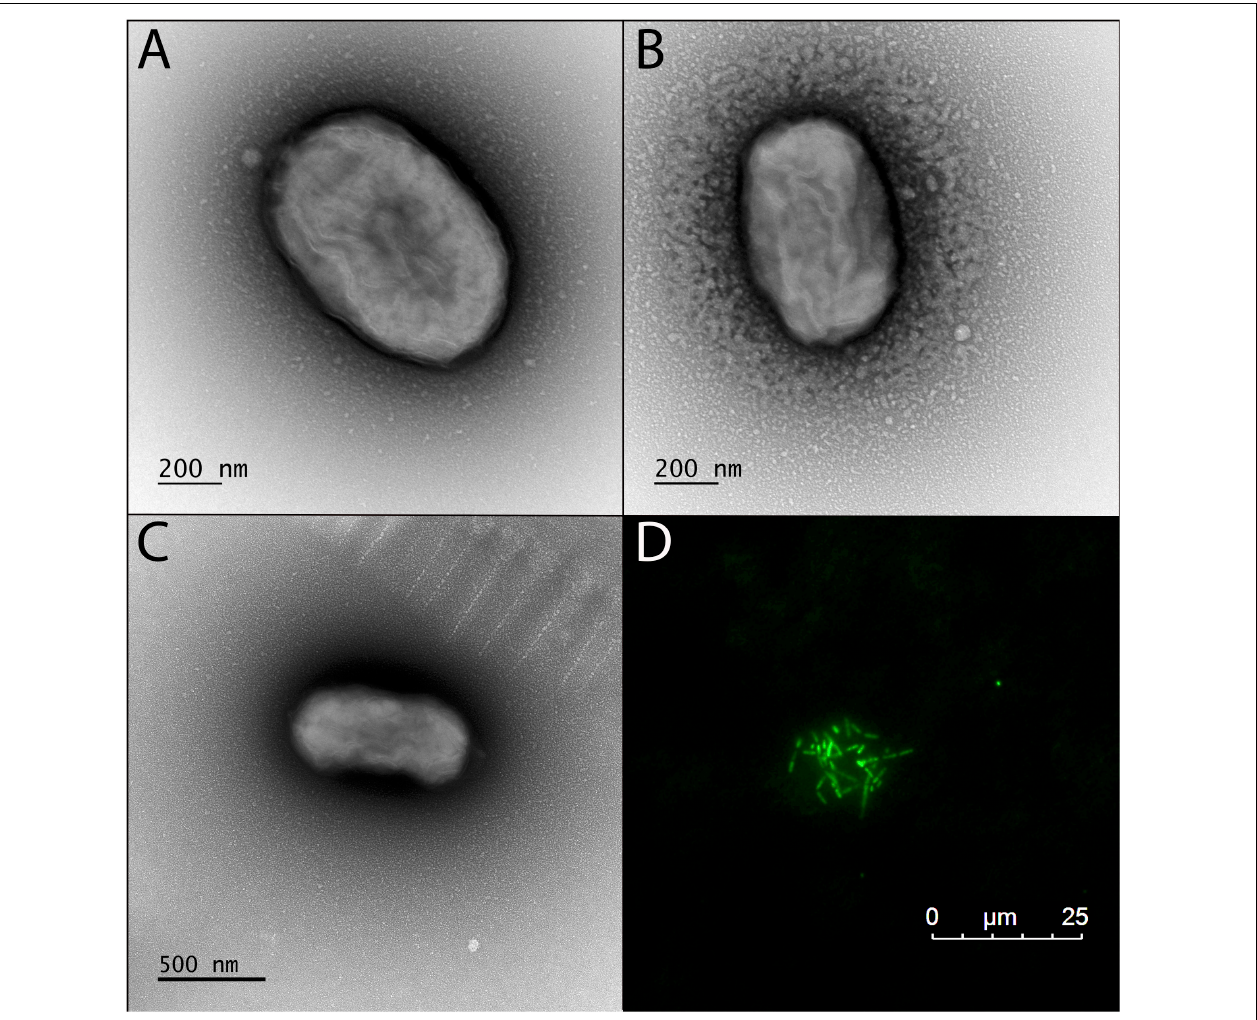
FIGURE 3 | Transmission electron microscopy (TEM) and fluorescence microscope images of the BLA1 enrichment grown in FW medium with Fe(II). (A–C) TEM; cell surfaces appear wrinkled, while still maintaining the structure of the cell, due to dehydration during TEM preparation. (D) Fluorescence image of live cells clustered on an Fe(III)